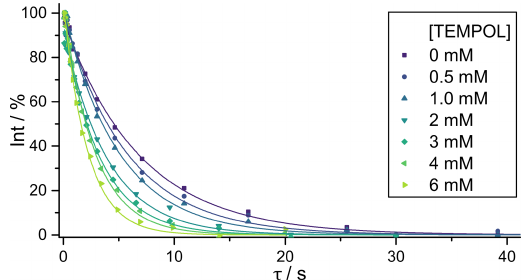
Figure 3. Decays of LLS-derived signals of DSS (compound I) for different TEMPOL concentrations. The LLSs were excited and re- converted by irradiation with single SLIC pulses applied to CH (1) with an RF amplitude of 27Hz to match the condition for single- quantum level anti-crossing (SQ LAC). The solid lines correspond to mono-exponential fits, scaled to begin at